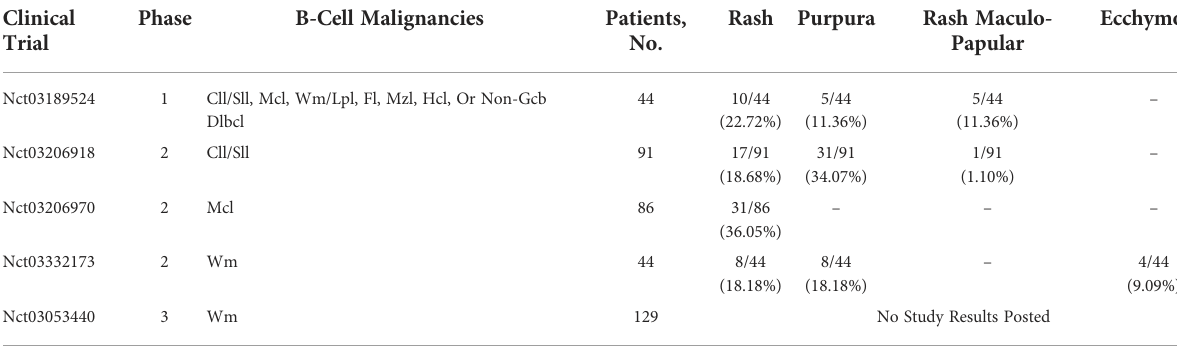
TABLE 1 Incidence Of Zanubrutinib-Associated Dermatological Toxicities. Clinical